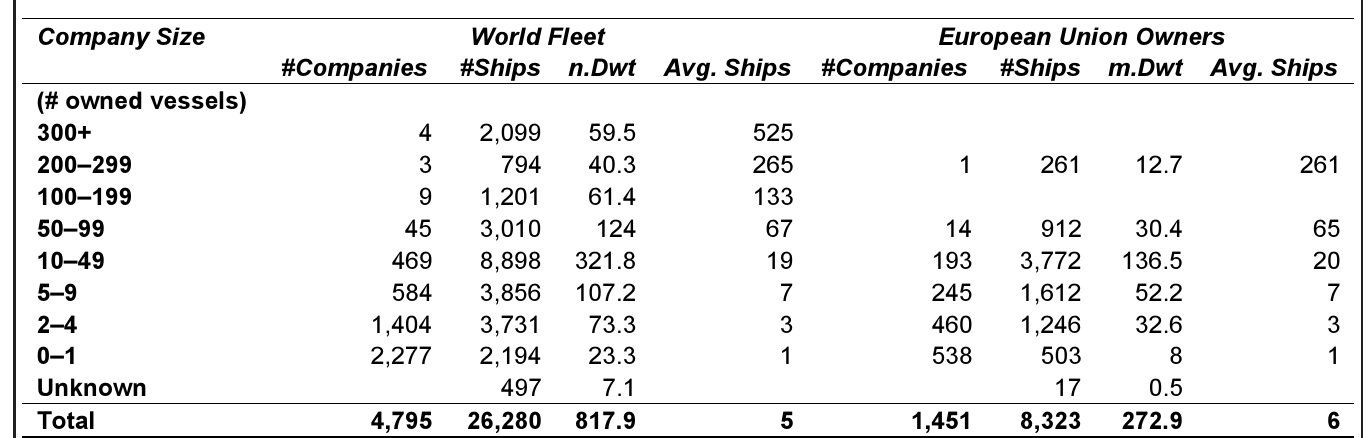
Table 1. Merchant Fleet by Company